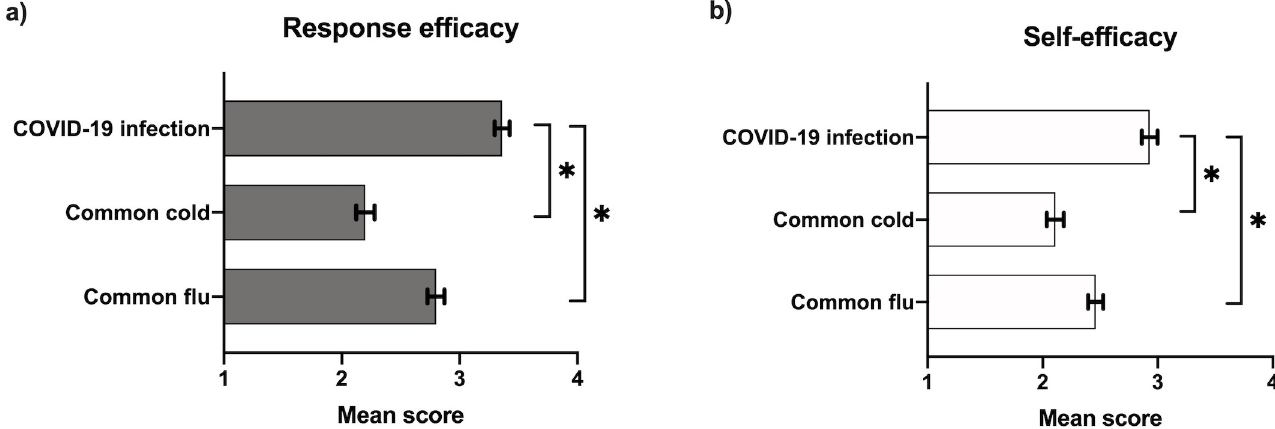
Fig 2. Mean scores of response efficacy and self-efficacy (scale 1–4) regarding common flu, coronavirus and common cold. Note : (a) Response efficacy question: Do you think it will help to take precautionary measures to protect yourself from “ disease ”? (b) Self-efficacy question: Do you think you could protect yourself from “ disease ”? Scores: 1 = not at all, 2 = a little bit, 3 = quite a bit, 4 = definitely. Error bars describe 95% confidence intervals. � Significance between means for a coronavirus infection compared to the two other diseases, p < 0.01, two-tailed.